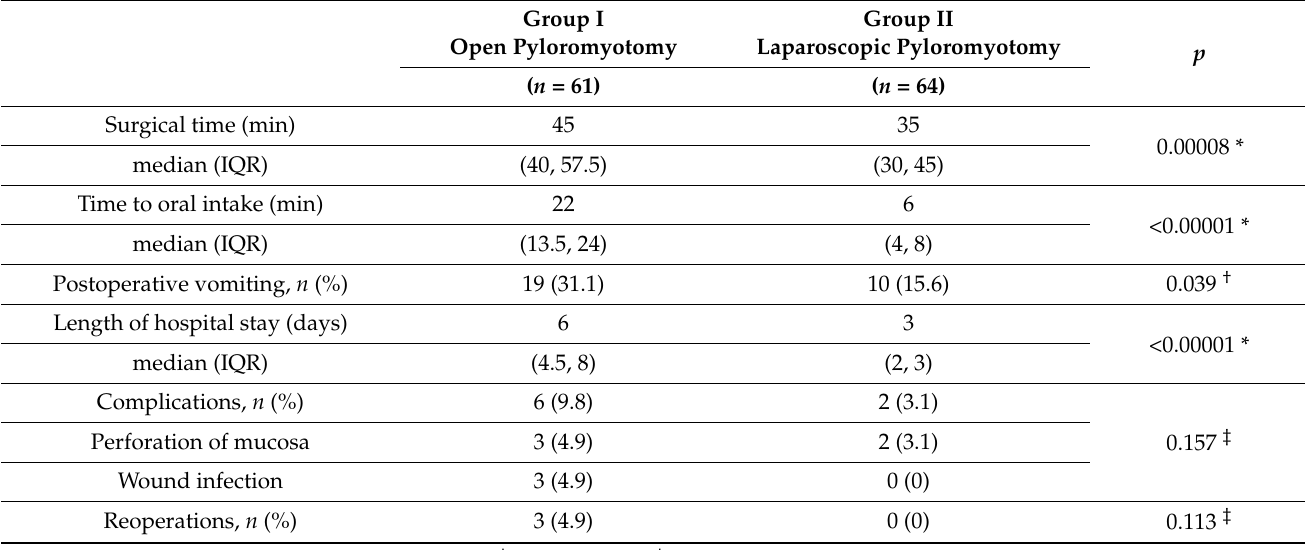
Table 2. Outcomes of